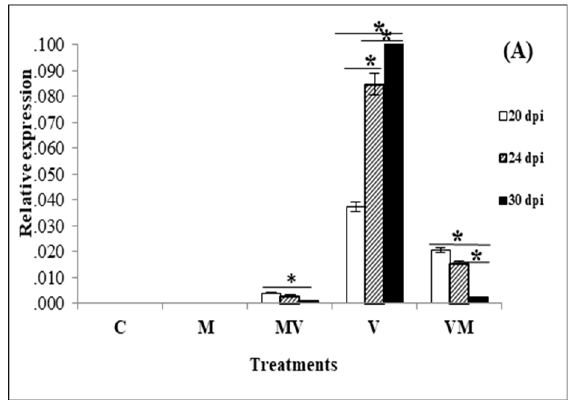
Figure 1. Disease severity of tomato plants infected by TBSV ( A ) and ToMV ( B ) at 20, 24 and 30 dpi (days post inoculation) of uninfected control plants without AM fungi (C), uninfected control plants with AM fungi (M) TBSV / ToMV-infected plants without AM fungi (V), TBSV / ToMV-infected plants before mycorrhiza (VM) inoculation and inoculated plants with mycorrhiza before TBSV / ToMV infection (MV). DS = Disease Severity for three replicates calculated. Significant di ff erence between the disease severity of treatments at three times is shown by (*) [using repeated measures ANOVA and Bonferroni post-hoc test ( p < 0.05)]. Error bars represent SD.